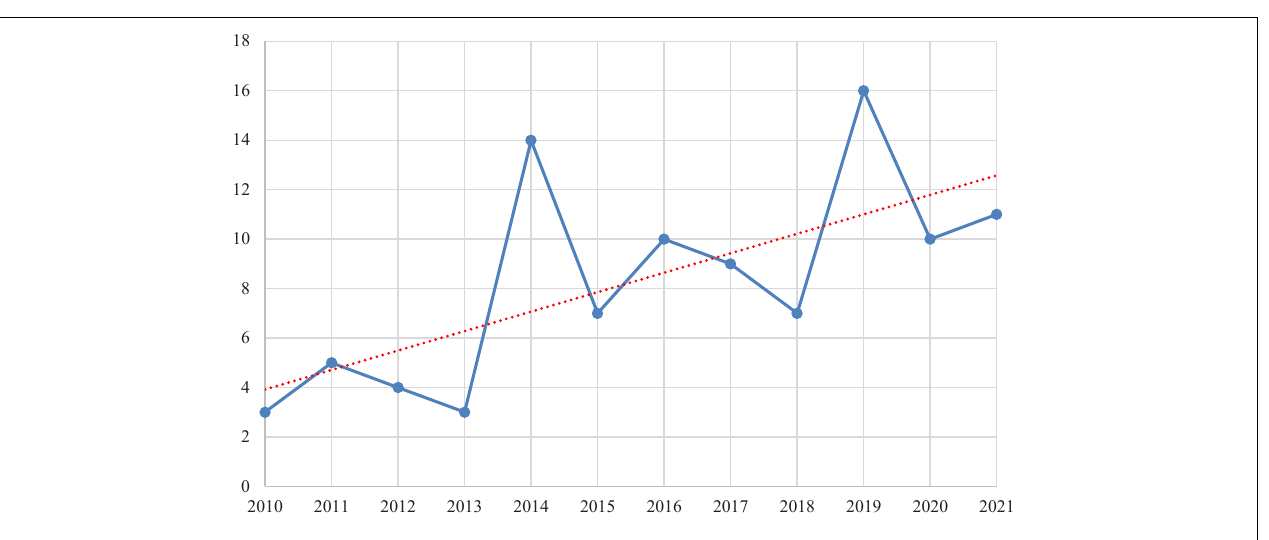
FIGURE 2 | Number of publications per year from 2010 to